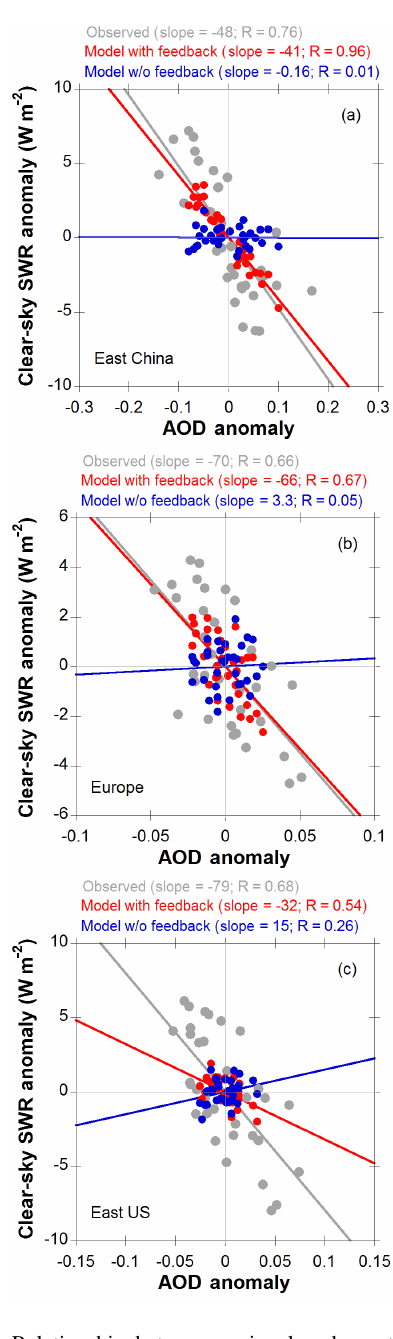
Figure 16. Relationship between regional and monthly average (only summer months) changes in aerosol optical depth and changes in clear-sky surface shortwave radiation during the 2001–2010 pe- riod for (a) eastern China, (b) Europe, and (c) the eastern United States. Observed values are shown in grey, CMAQ calculations with direct aerosol radiative feedbacks in red, and CMAQ calculations without aerosol radiative feedbacks in blue. Also indicated are the slope and correlation coefficient ( R ) for the individual linear re- gressions. For each data set (model or observed) there are 33 values, corresponding to each summer month over the 11-year (2001–2010) period. The anomaly is estimated by subtracting the corresponding 11-year average for that